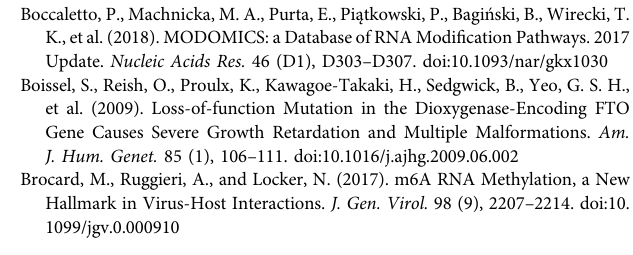
Frontiers in Cell and Developmental Biology |